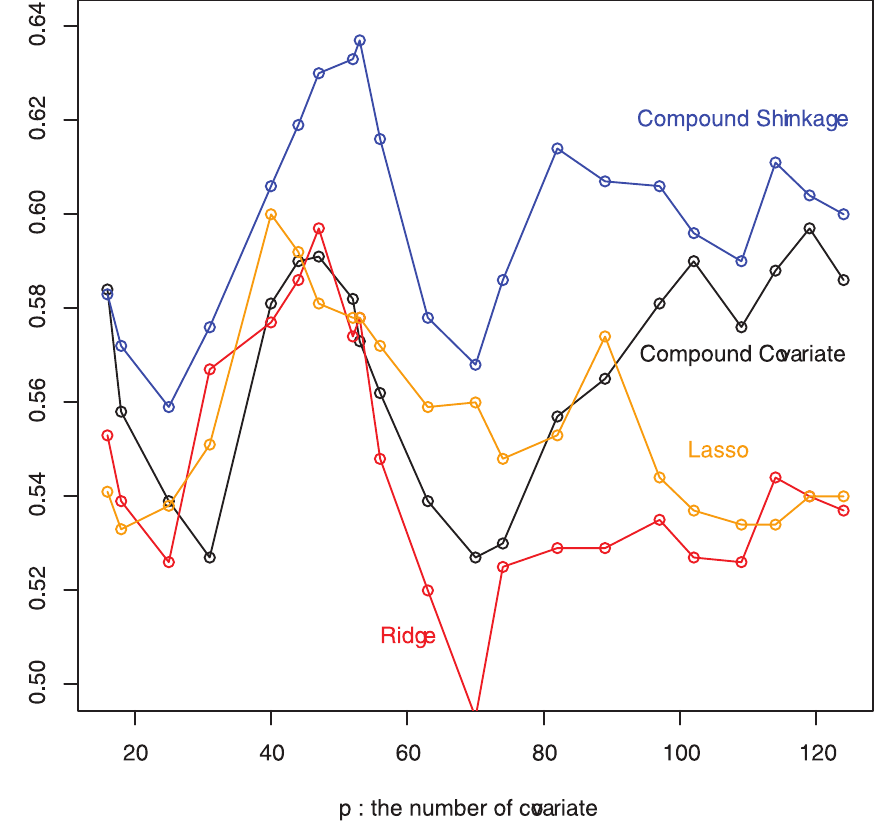
Figure 4. The c -index assessments of the four methods under varying number of top genes ( p =16 , 124 ) in the lung cancer data of Chen et al. [ 6 ] , where ‘‘top genes’’ refer to most strongly associated genes passing a univariate pre-filter for inclusion in the linear predictor (PI).